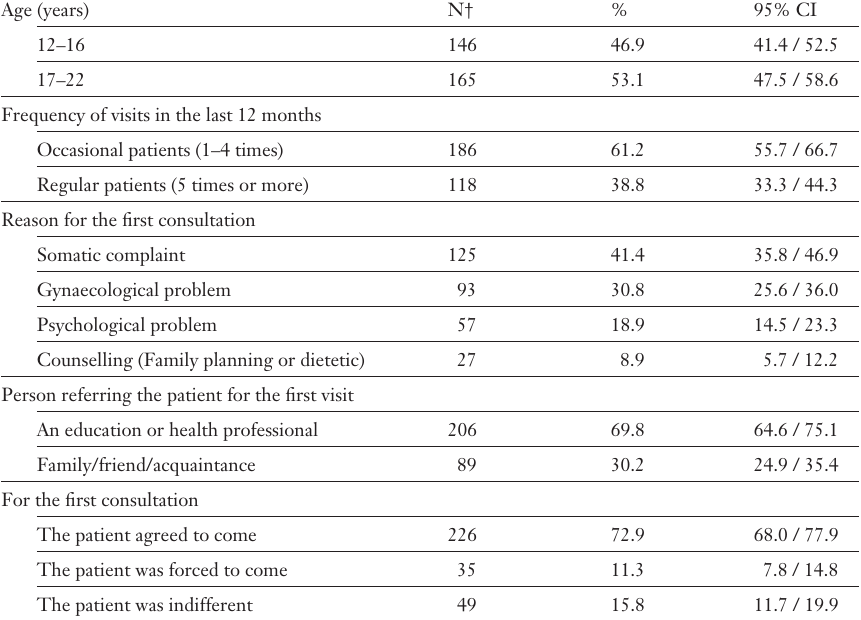
Background charac- teristics of female patients.